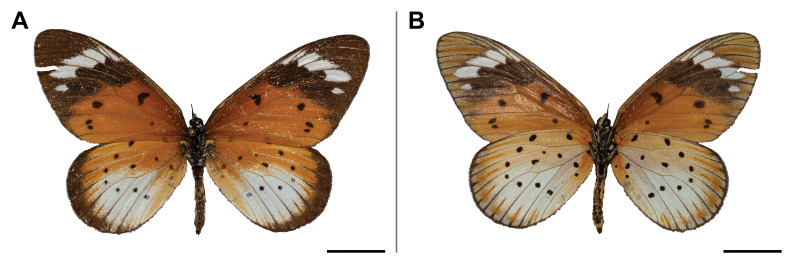
Telchinia
encedana (Pierre, 1976). A. dorsal view; B. ventral view. The scale bar represents 1 cm.